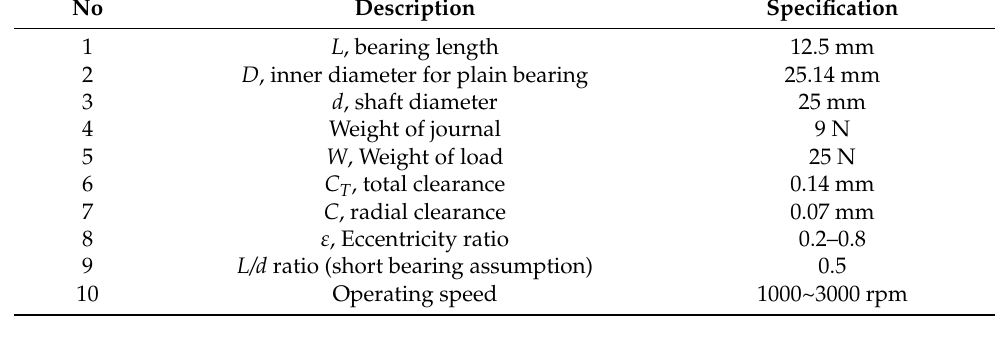
Figure 1. ( a ) Journal bearing schematic; ( b ) overall diagram of Journal Bearing Test Rig (JBTR).